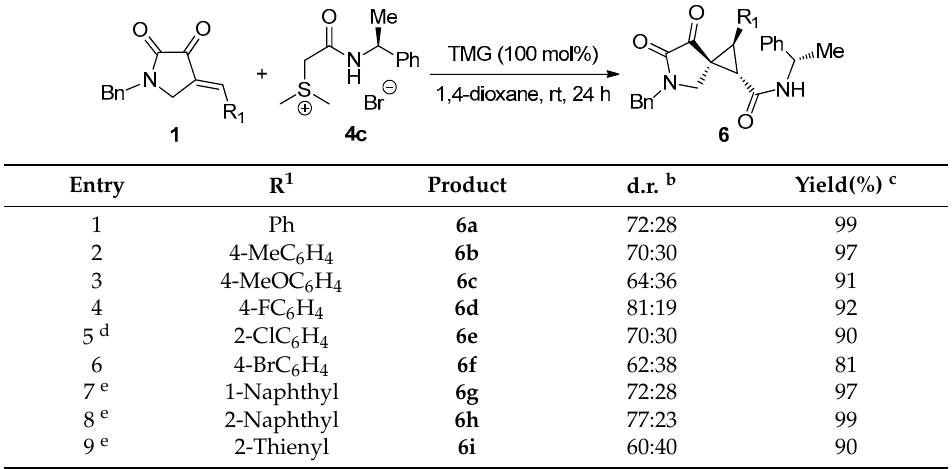
Table 5. Substrates scope of cyclopropanation of cyclic enones 1 with chiral sulfonium salt 4c a .